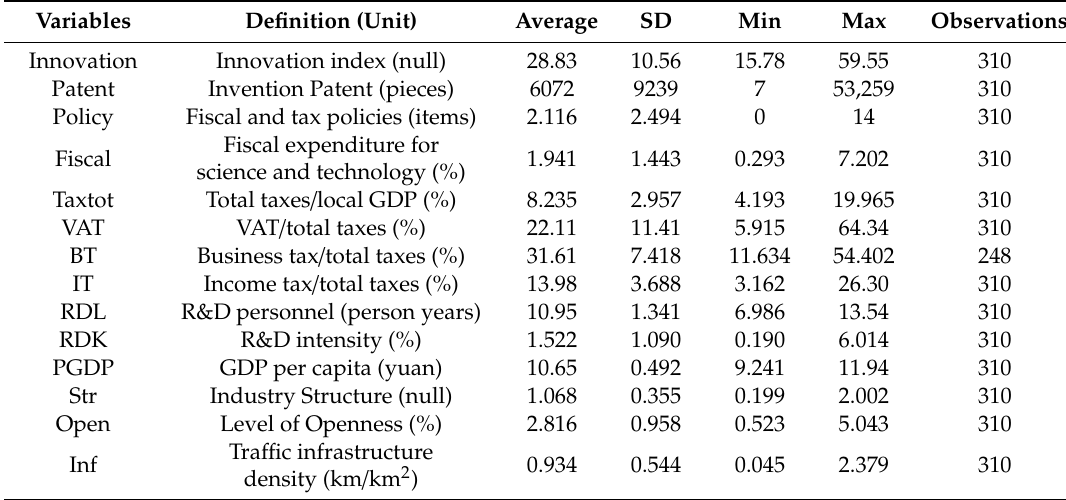
Table 3. Descriptive statistical analysis of